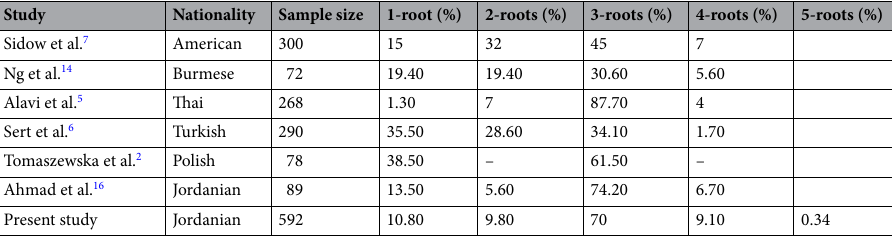
Table 5. Percentage of root number of maxillary third molar in previous studies and the present one.